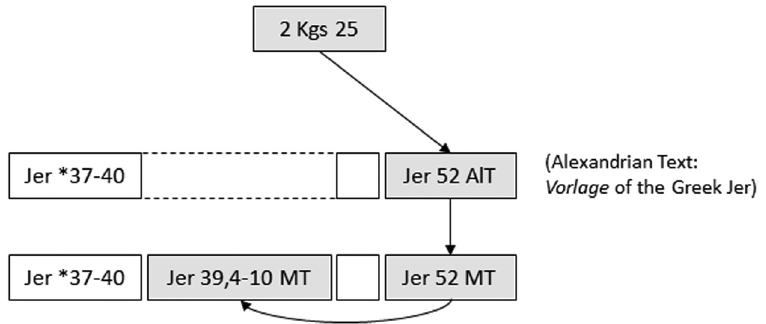
Figure 1: Schematic representation of the chronological order and literary relations of the four parallel accounts presupposed in the